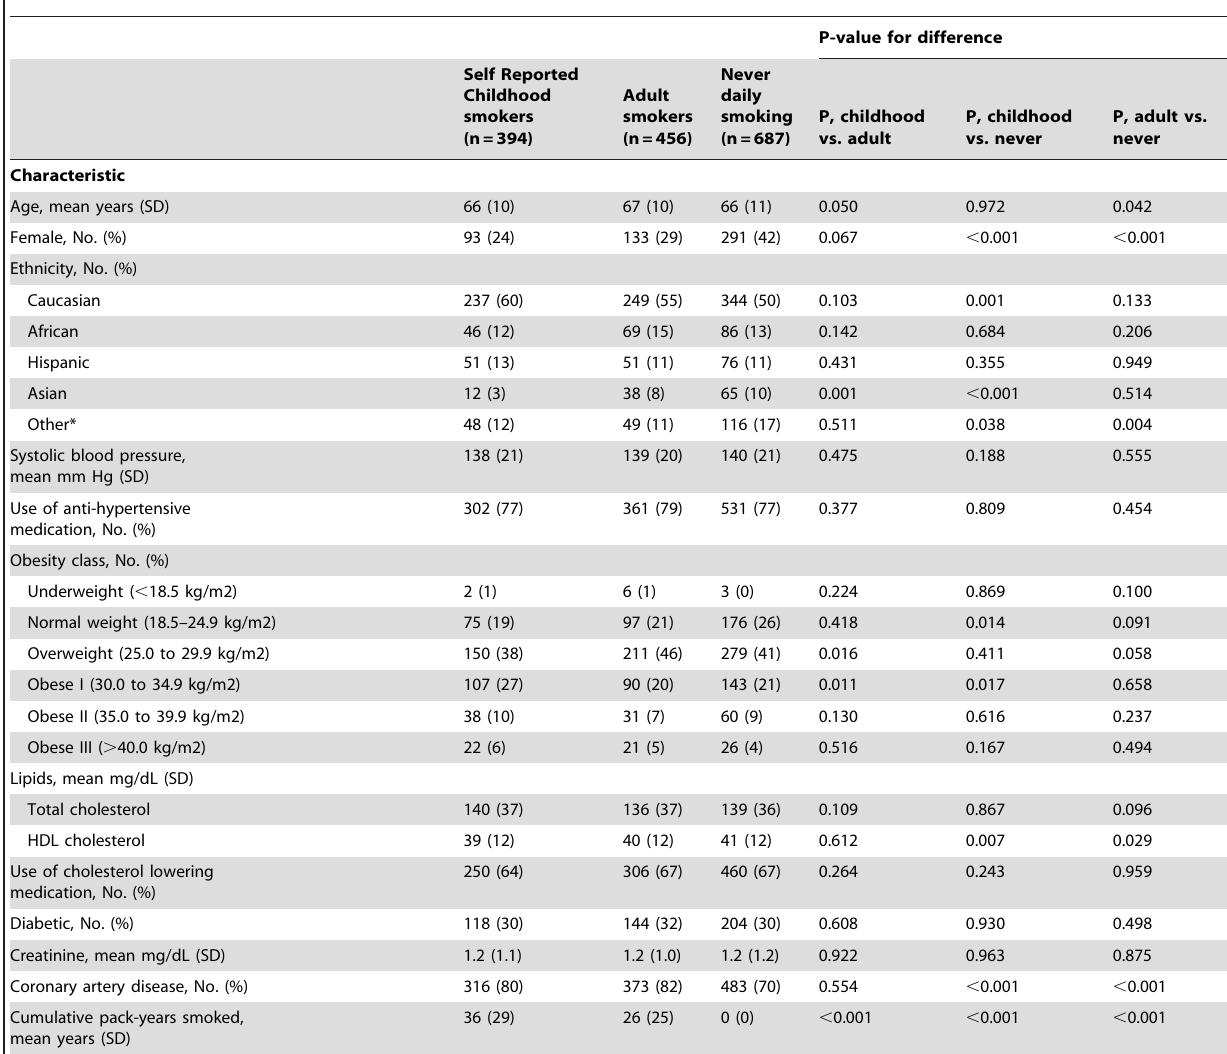
Table 1. Baseline study population characteristics (n=1,537).